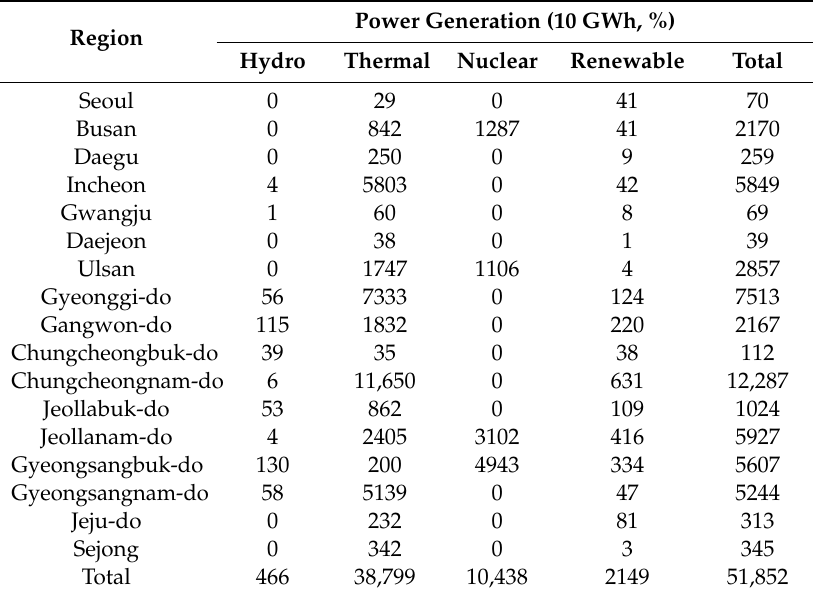
Table A1. Power generation by regions.